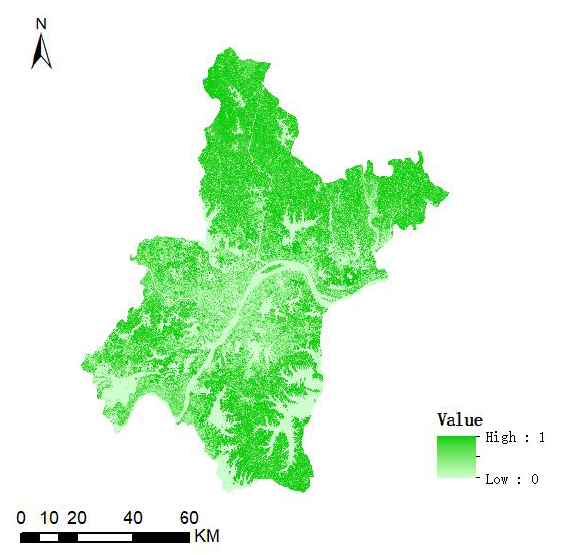
Figure 3.The fractional vegetation cover of Wuhan